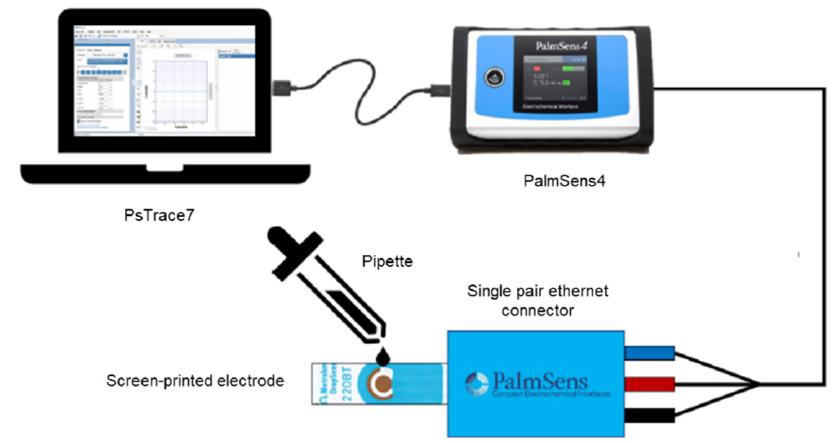
Figure 1. Experimental set-up